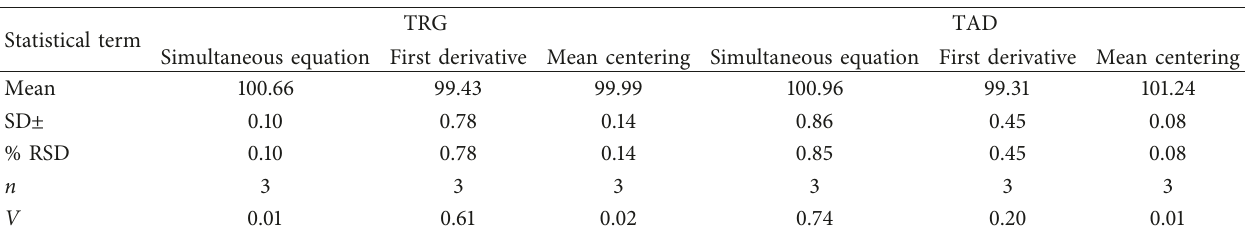
Table 4: Statistical comparison between the proposed spectrophotometric